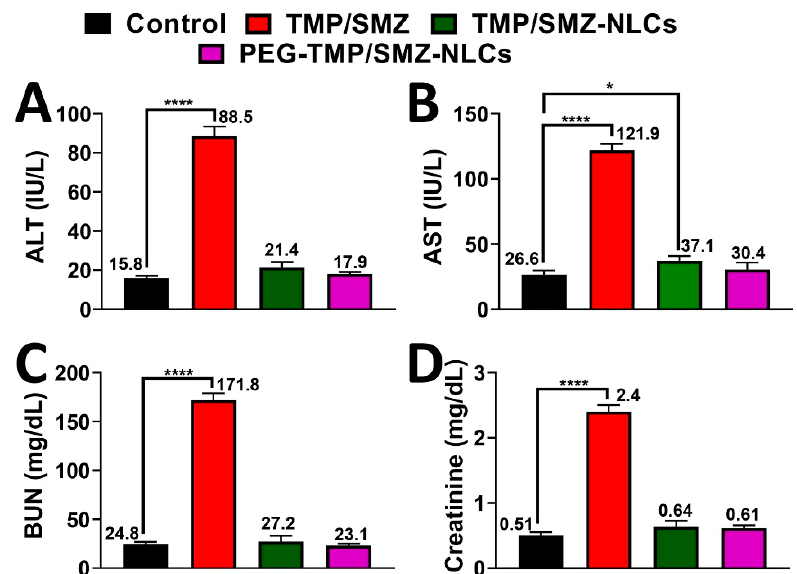
Figure 8. Serum levels of ( A ) alanine aminotransferase (ALT), ( B ) aspartate aminotransferase (AST), ( C ) BUN, and ( D ) creatinine in TMP/SMZ, TMP/SMZ-NLCs, and PEG-TMP/SMZ-NLCs groups compared to the control group. The results were expressed as mean ± SD from three independent experiments. * and **** indicate p < 0.05 and <0.0001, respectively, compared with the control group.